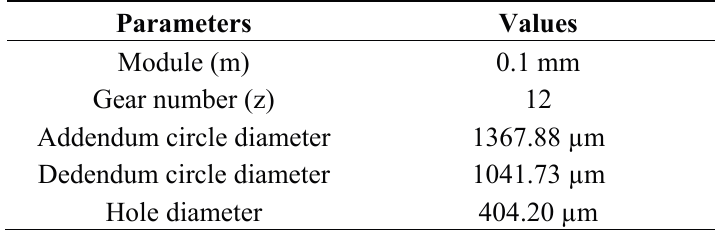
Figure 2. ( a ) Top view and details of the punching die; ( b ) sectional view of the punching die; and ( c ) dimension of designed tooth profile. Table 2. Dimensional characteristics of the mold.